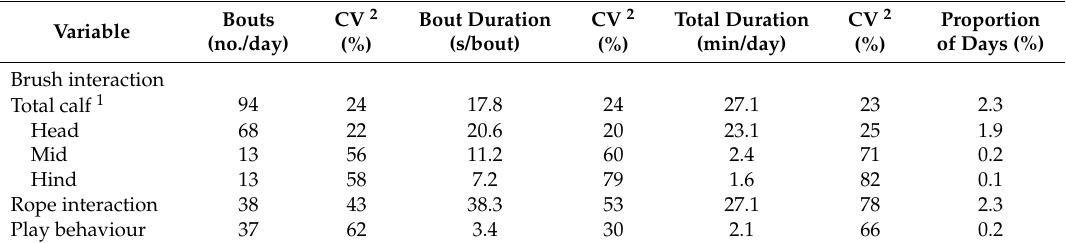
Table 2. Descriptive statistics for brush use, rope use, and play behaviour of 7 calves averaged for 3